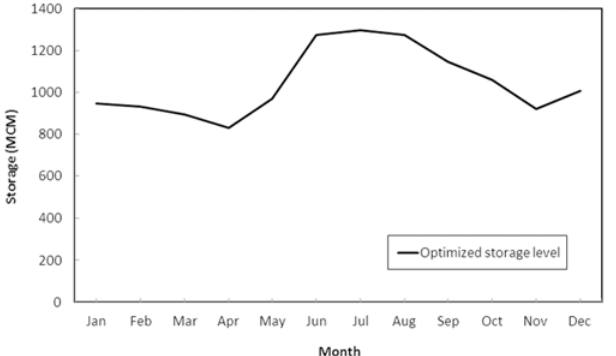
Fig 6. Optimal level of storage that results in the maximum long-term utility of the water users and reservoir operator in every month of the